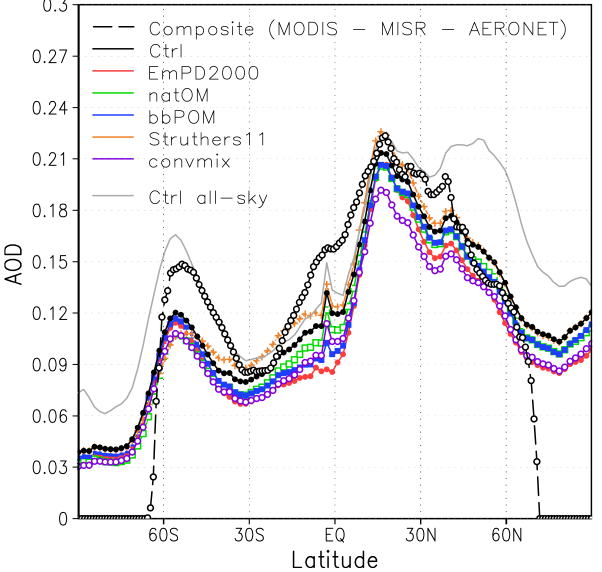
Fig. 6. Zonally and annually averaged clear-sky aerosol optical depth (AOD) at 550nm from ground- and satellite-based retrievals (S. Kinne, personal communication, 2007), and calculated with CAM4-Oslo for year 7 of the Ctrl experiment and a selection of sensitivity tests. For comparison with the clear-sky AOD, also all- sky AOD at 550nm is shown for the Ctrl simulation (gray solid line).